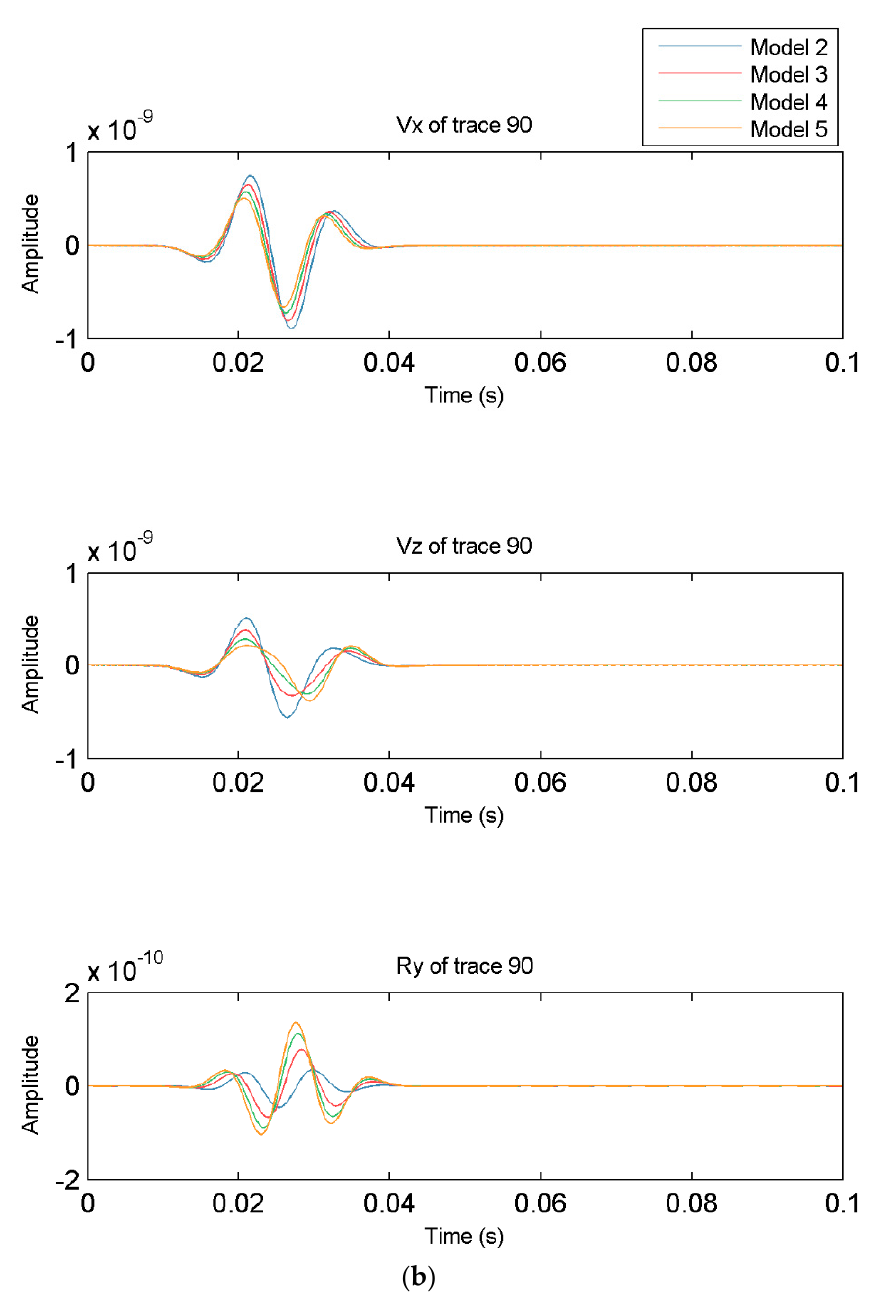
Figure 8. Influence of ε on seismic records generated from the expansion source: ( a ) the seismic records of the 30th trace; ( b ) the seismic records of the 90th trace.